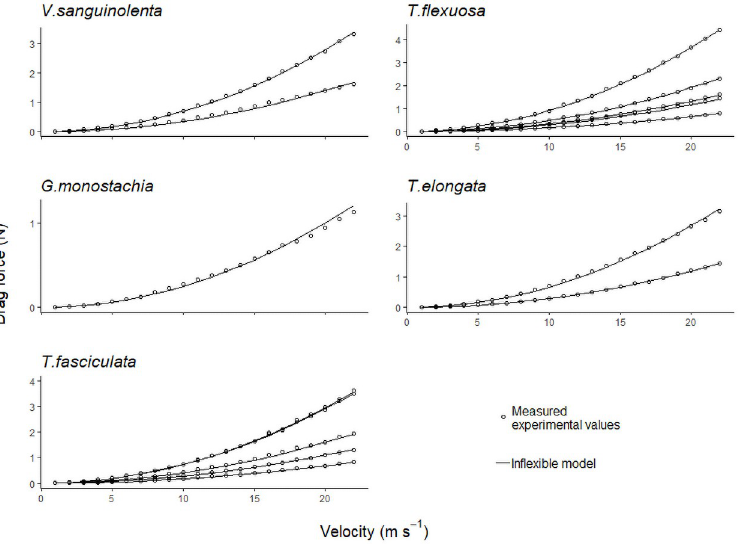
Fig 4. The relationship of drag force and flow velocity. Shown are fitted values (—) of drag force expected on rigid specimens calculated using Eq 1, and measured values ( � ) on rigid specimens in the wind